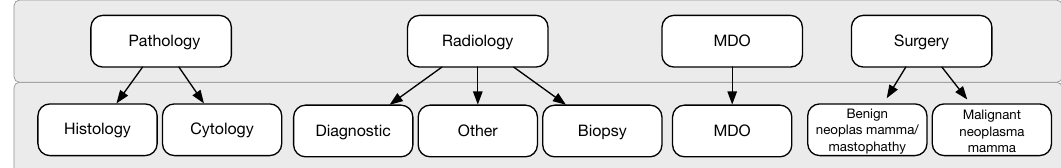
Figure 7. Event types on different levels of granularity (level 1 on top, level 2 at the